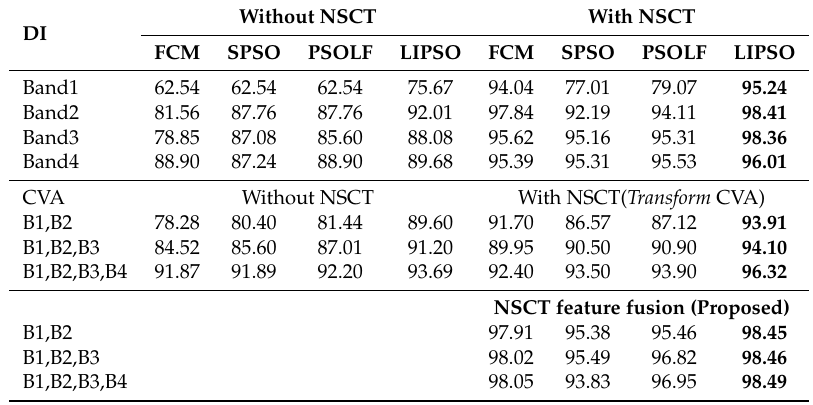
Table 3. OA obtained for FCM [3], SPSO [47], PSOLF [43], LIPSO (proposed) of Malambuzha Dam, Kerala data set ; OA = Overall